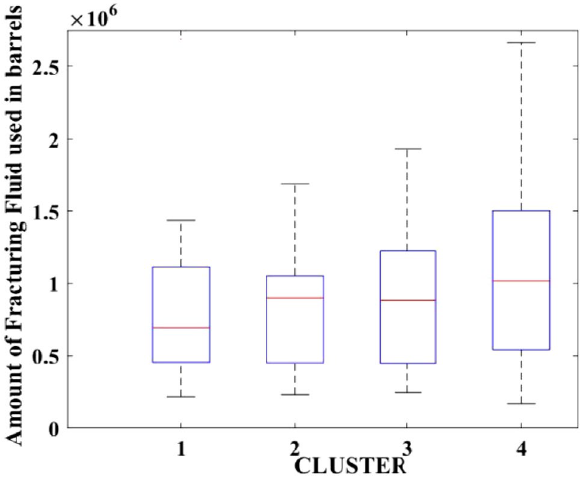
Figure 4. Amount of fracturing fluid used.